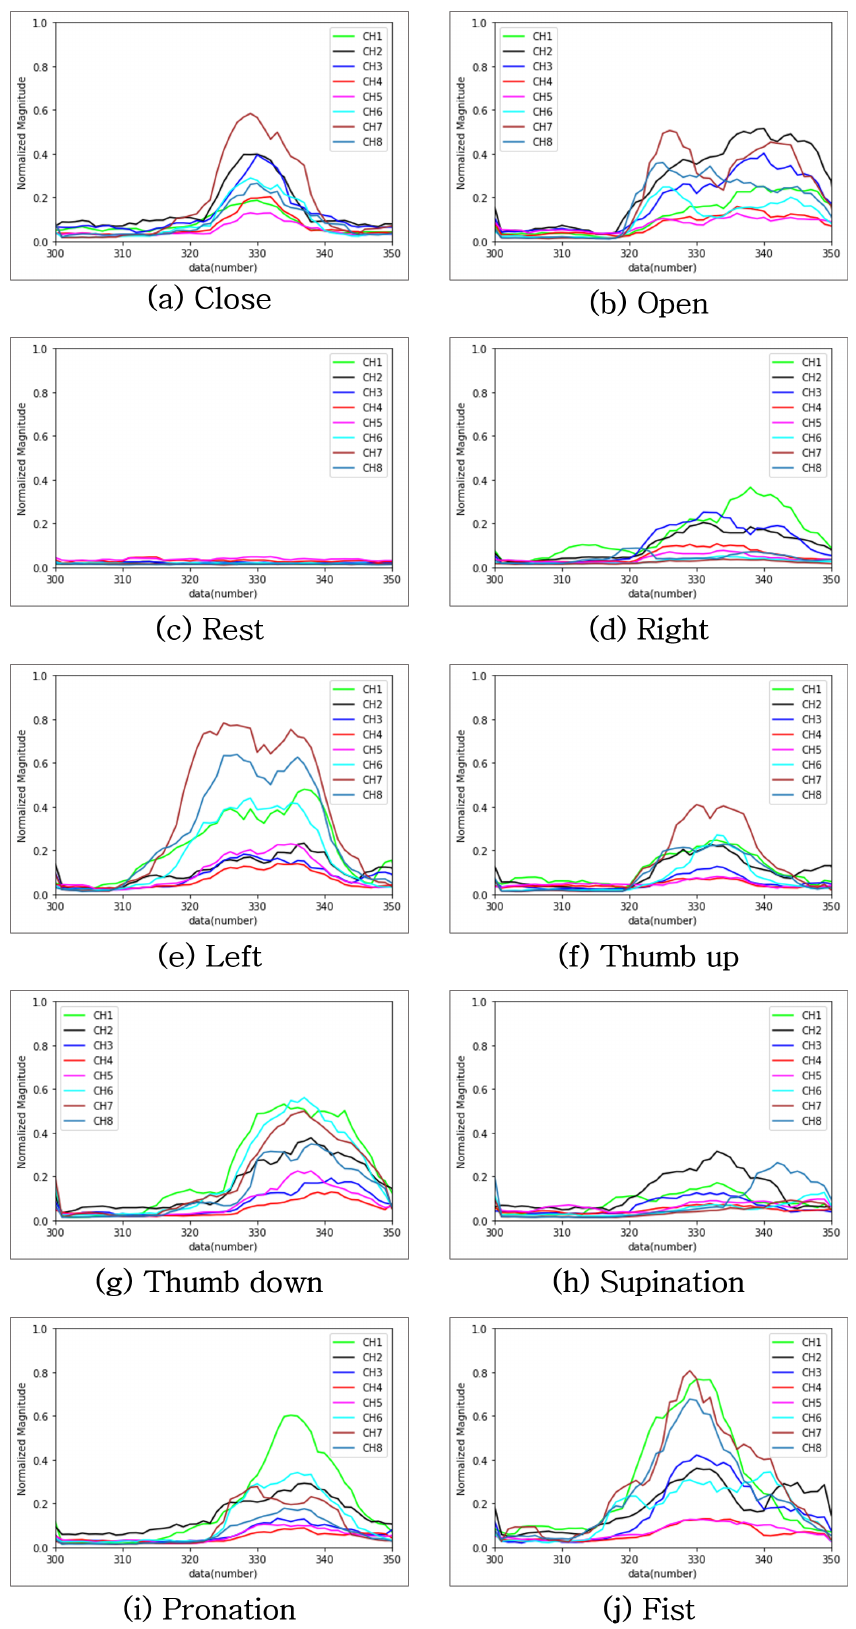
Figure 7. Plots of data collected using the Myo armband. Each gesture is represented by a graph of eight channels. The characteristics of each gesture can be observed in this